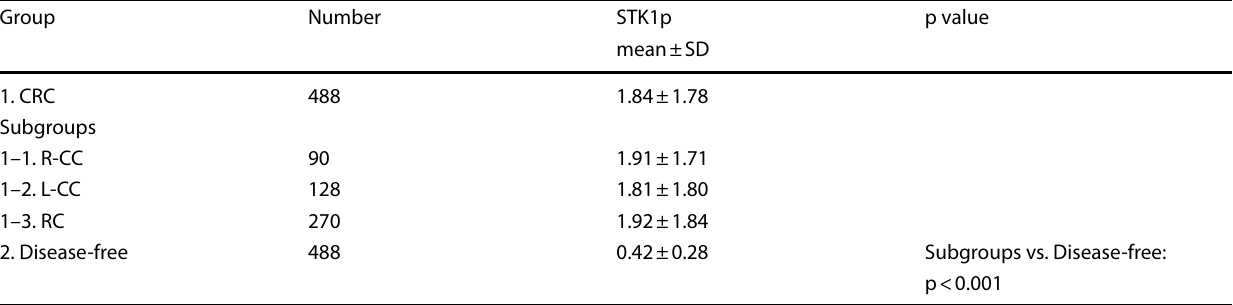
Table 1 STK1p values in PTL of CRC patients and disease-free persons. The PTL of CRC patients was divided into three different subgroups (1–1. R-CC; 1–2. L-CC;1–3. RC) Group